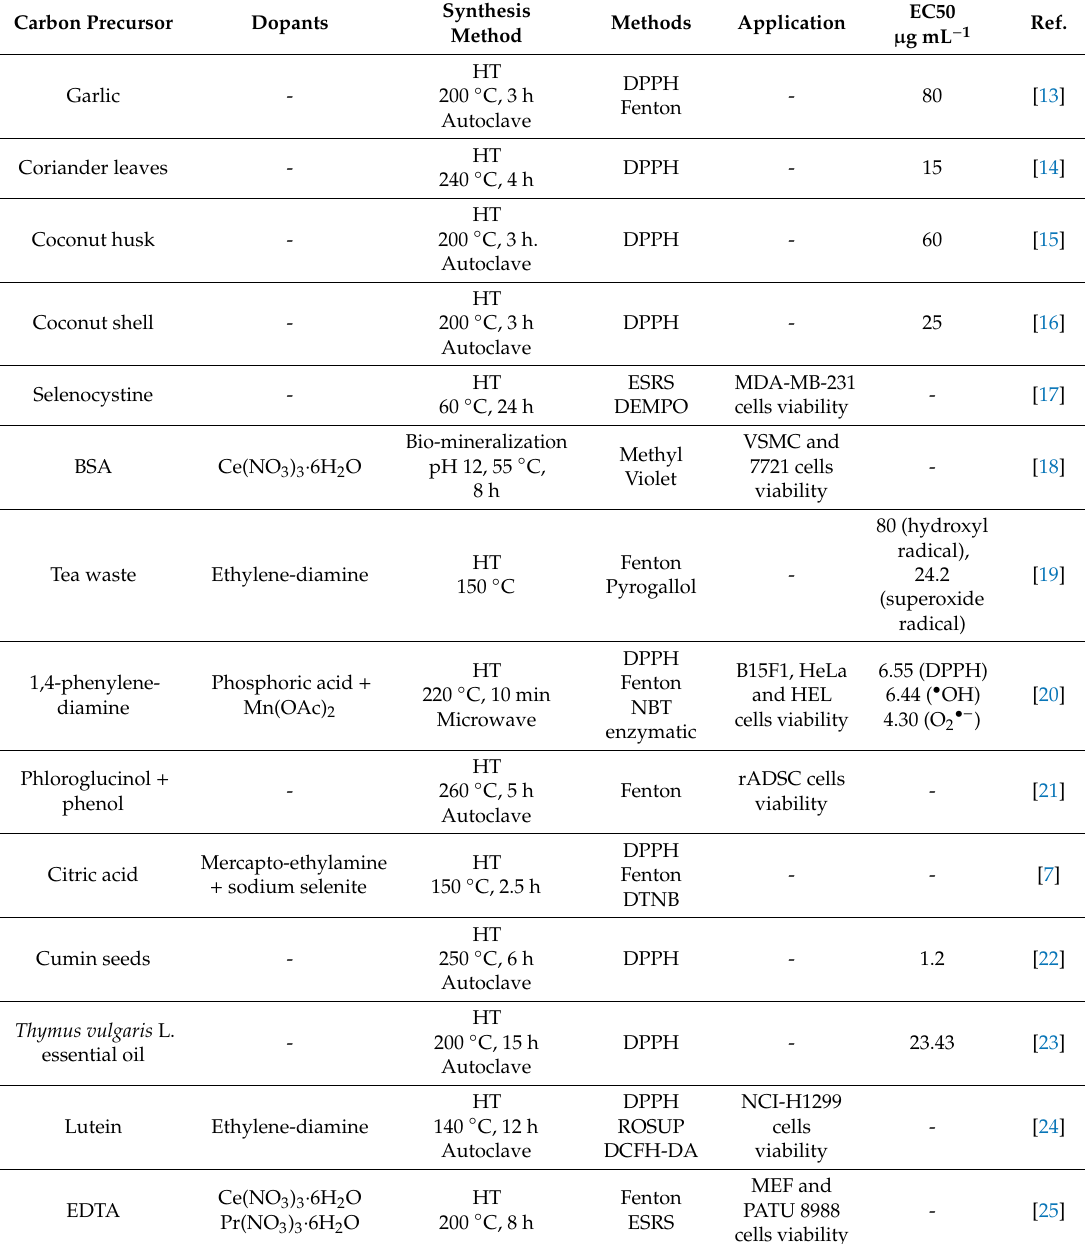
Table 1. Carbon dots with antioxidant properties, precursors and